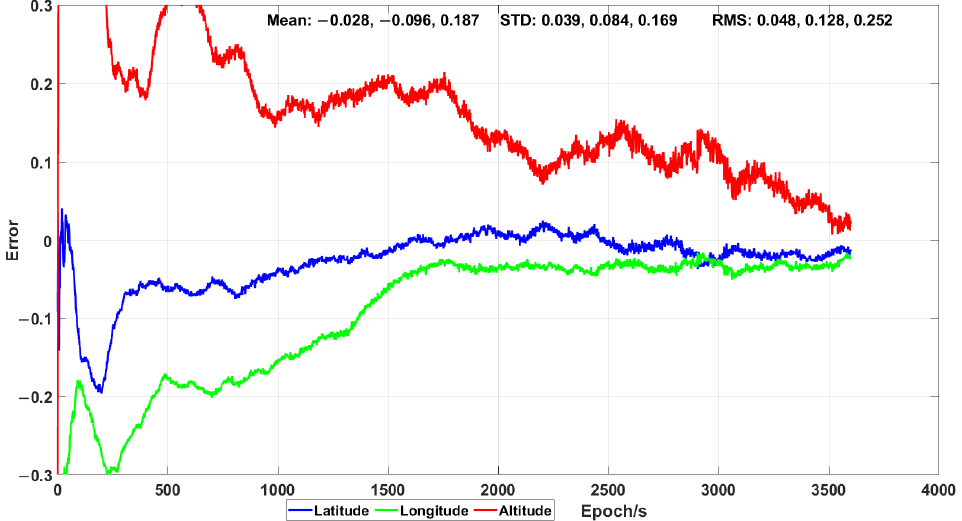
Figure 16. Positioning error (expressed in metres) obtained by means of PPP during the dynamic test.